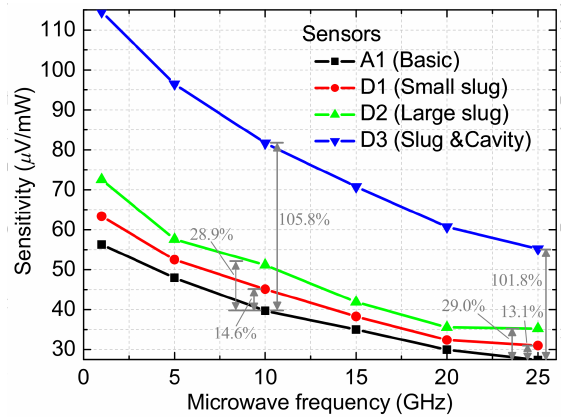
Figure 9. Average sensitivity as a function of the microwave frequency for the basic and improved MEMS power sensors.